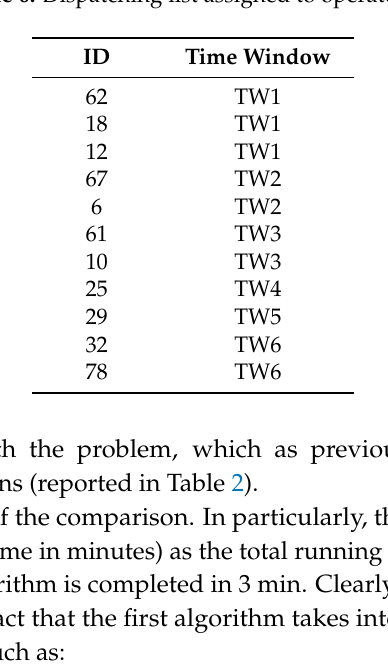
Table 6. Dispatching list assigned to operator 8.